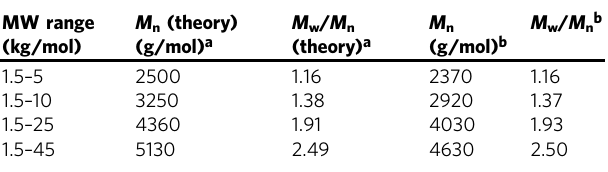
a Values are from MATLAB code. b Data obtained from GPC(THF) with respect to PS